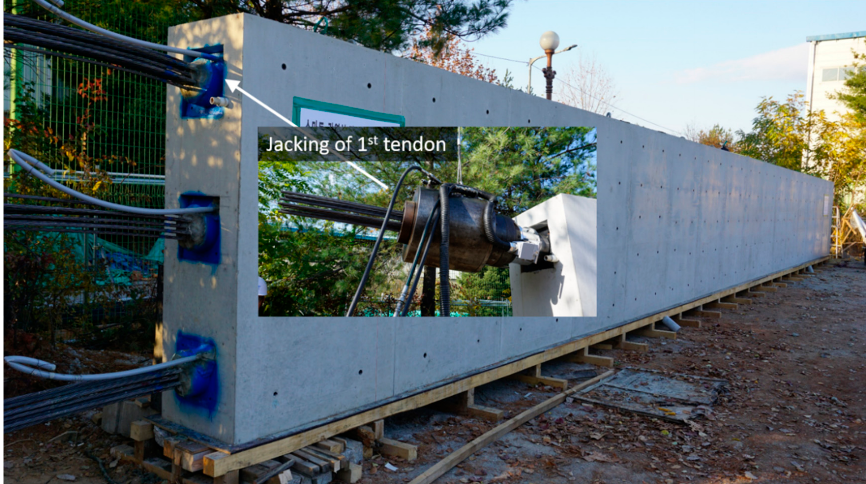
Figure 7. Shape of specimen and jacking process .